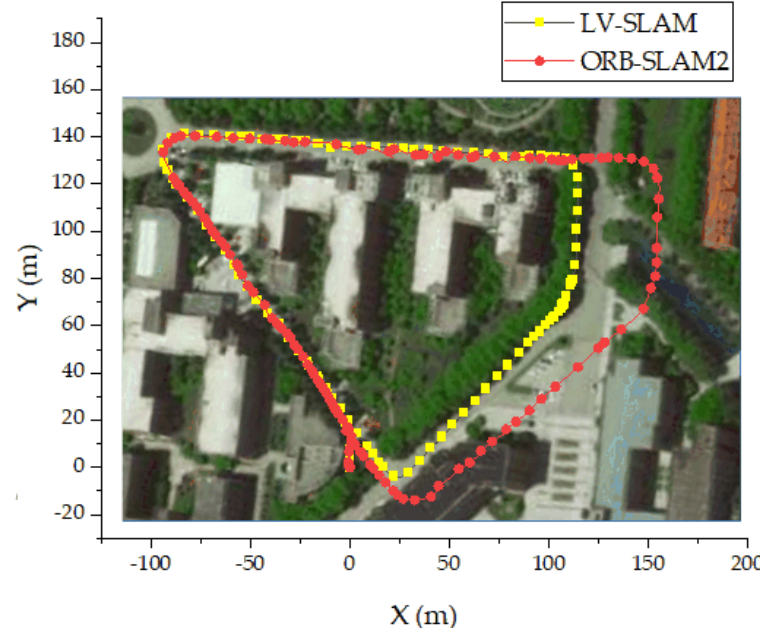
Figure 11. The trajectory of the mobile robot.